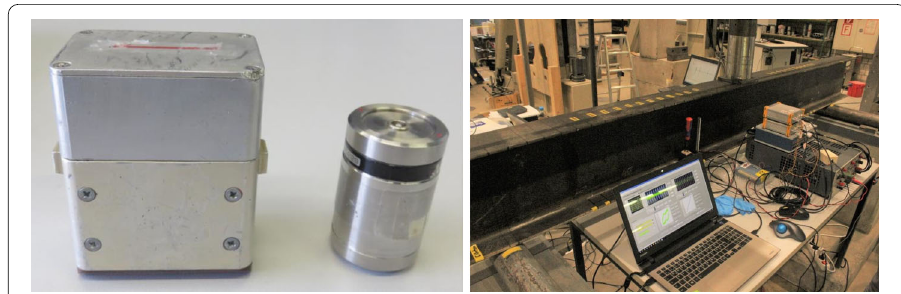
Figure 3 Left: Both sensors for recording ultrasonic runtimes and micromagnetic. Right: A coated steel beam in the lab with devices to record ultrasonic signals as well as micromagnetic quantities. The notebook in front shows hysteresis curves surveilling the micromagnetic records used for the determination of the yield strength